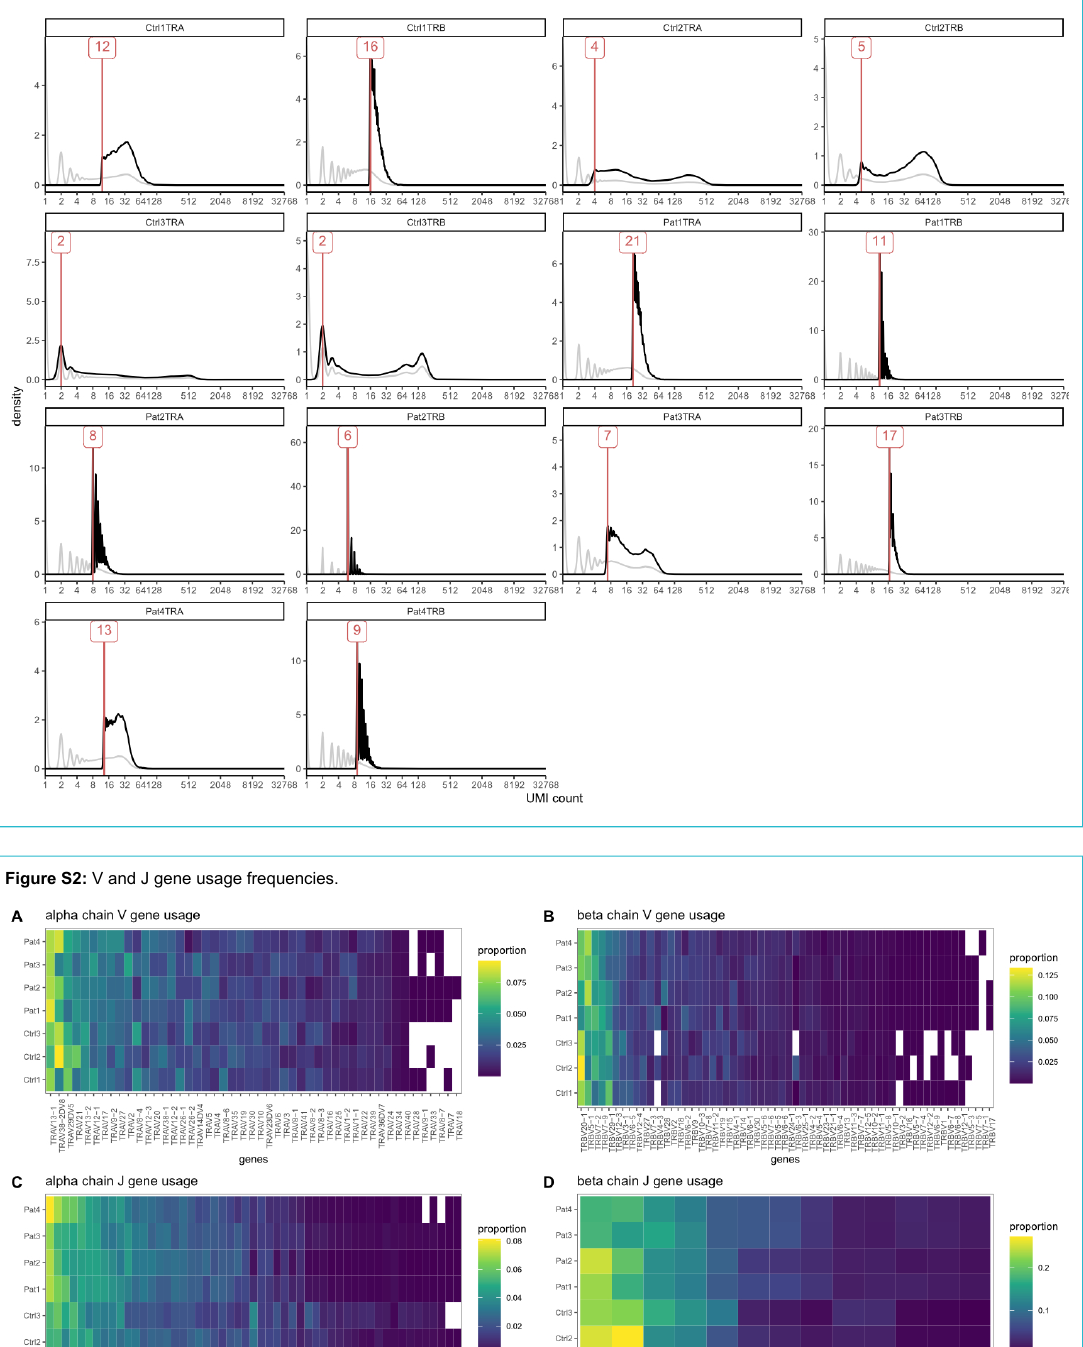
Figure S1: Unique molecular identifier coverage plots showing subsampling impact. Coverage of total reads is shown in grey, coverage after subsampling in black, resulting thresholds to subsample to equal number of 13,139 sequences are indicated in red. Ctrl3_TRA was used as reference because of the lowest number of initial reads and threshold for this sample was set to 2 in order to remove singletons.